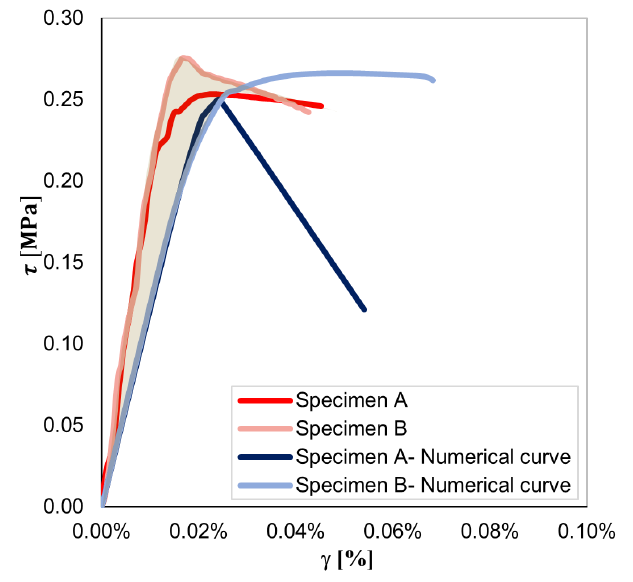
Figure 7. Numerical versus experimental shear stress–strain curves obtained for the tested masonry wall specimens.